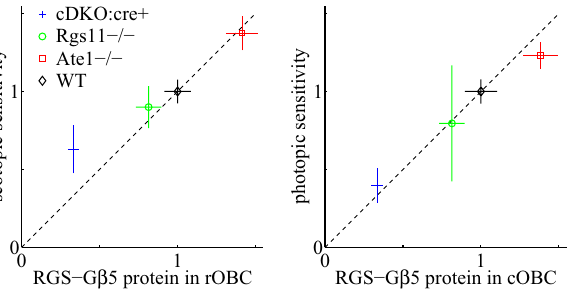
Figure 8. The ON bipolar light sensitivities monotonically increase with the RGS-G β 5 protein levels. The scotopic and photopic ERG sensitivities are plotted against the RGS-G β 5 protein levels in the dendritic tips of rod-OBC (rOBC) and cone-OBC (cOBC) on the left and the right, respectively. The data points for the wild type (WT) and the conditional Ate1 knockout (Ate1-/-) mice are from the current study, for which the levels of RGS- G β 5 are represented by the immunostaining levels of G β 5 , the obligatory heterodimer binding partner of both RGS7 and RGS11. The data points for the RGS11 knockout (Rgs11-/-) and the tamoxifen-induced, conditional Rgs7 knockout of Rgs11-/- background (cDKO:cre+) mice are derived from 62 , for which the levels of RGS- G β 5 protein are represented by the immunostaining levels of RGS7 (no RGS11). The cDKO:cre+ data point is from mice with 12 days of tamoxifen administration (RGS7 level was significantly reduced but not completely eliminated yet). All the values are normalized to the corresponding ones of WT. The cDKO:cre+ values (at day 12) are first normalized by the corresponding ones at day 0, and then normalized with the Rgs11-/- together by the WT values from 62 . The normalized level of RGS protein in Rgs11-/- is estimated to be 35/43. This is derived from 20 RGS7 and 23 RGS11 (fmol/10mg) in WT, and 35 RGS7 (fmol/10mg) in Rgs11-/- 62 . The ratio of 35 to 20 RGS7 in Rgs11-/- versus WT is also consistent with 30 .